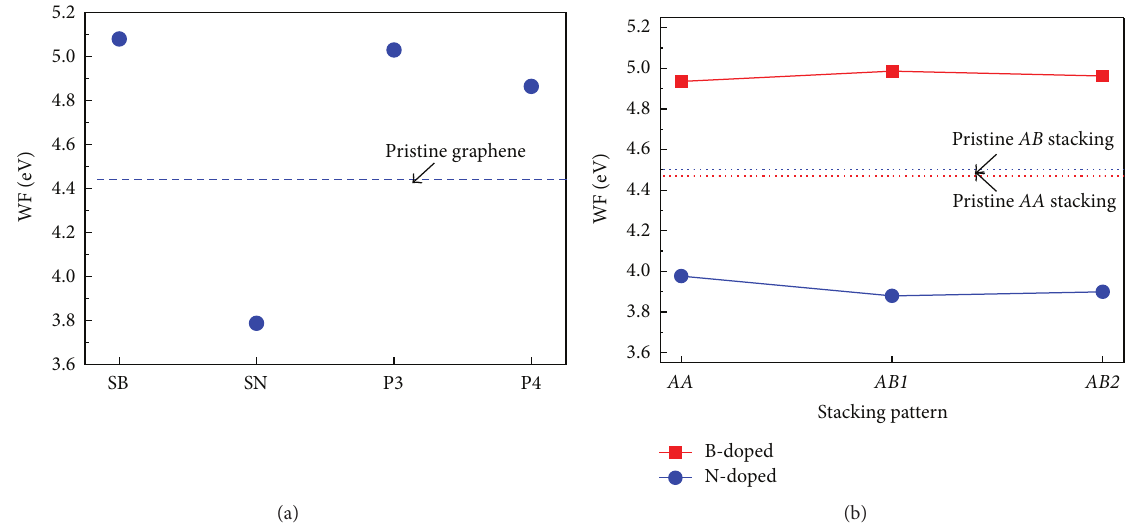
Figure 9: Work functions of pristine and B(N-) doped (a) monolayer with the substitutional B (SB), the substitutional N (SN), the trimerized pyridine-type (P3), and the tetramerized pyridine-type (P4) defects and (b) bilayer graphenes with AA , AB1 , and AB2 stacking. The horizontal broken lines denote pristine monolayer and bilayer graphenes. (b) is taken from [57]. Reproduced with permission from [57], copyright 2015,